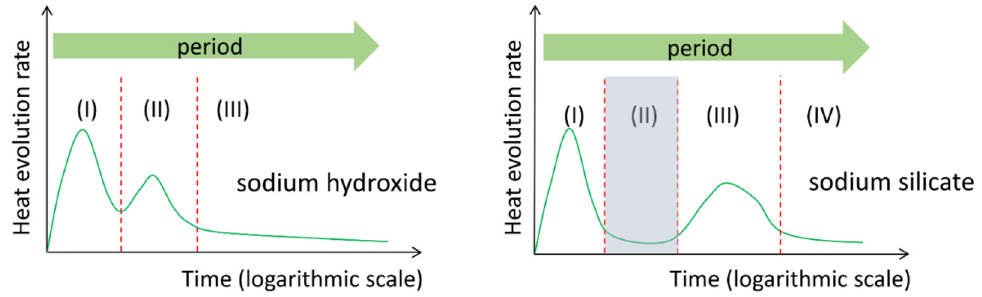
Figure 1. Schematic representation of the heat evolution rate curves of NaOH activated slag paste and sodium silicate activated slag paste. The shadowed part refers to the induction period.